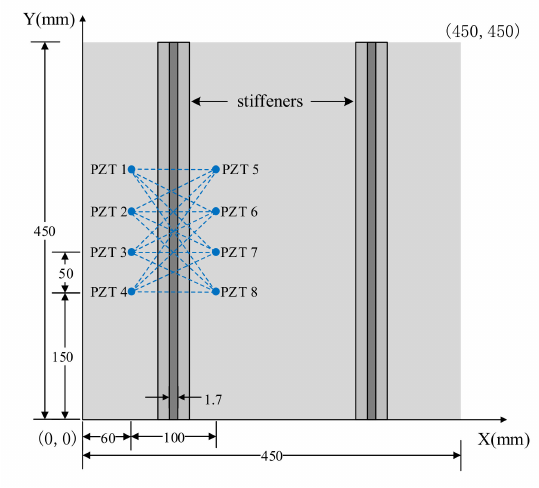
Figure 11. The positions and paths of the sensors.